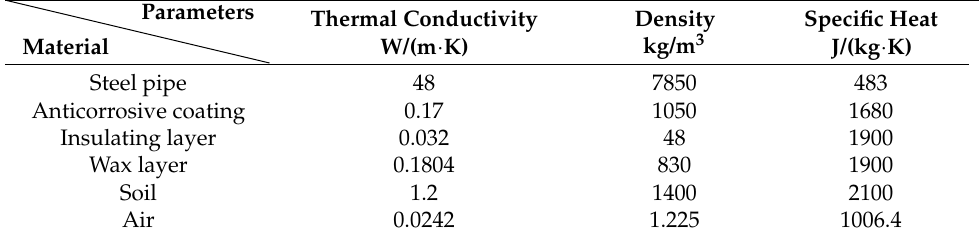
Table 1. Properties of the materials used in the modeling.